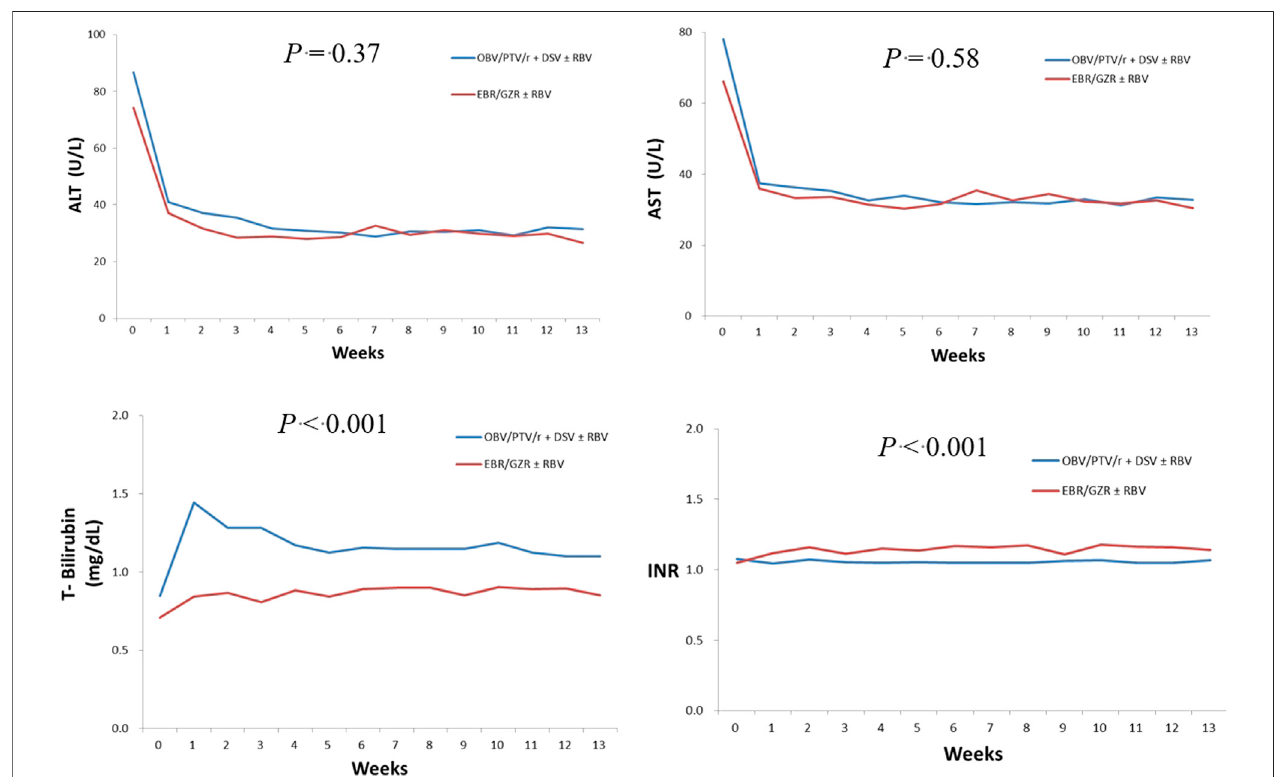
FIGURE 3 | Laboratory